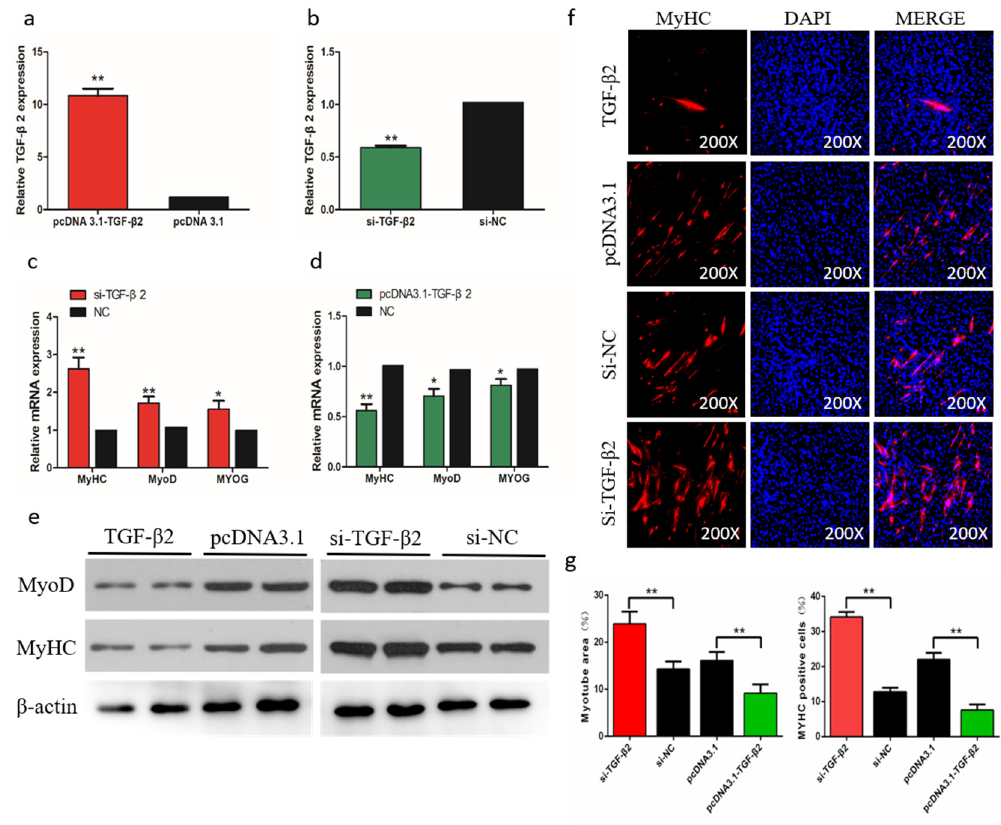
Figure 8. Effects of TGF- β 2 on differentiation of skeletal muscle satellite cells (SMSCs). ( a , b ) After overexpression or interference with TGF- β 2, qRT-PCR was used to detect the expression of TGF- β 2 in SMSCs. ( c , d ) The relative expressions of MyoD, MyHC, and MyoG mRNA in SMSCs differentiated for 48 h. ( e ) Western blot detects protein levels of myogenic marker genes after inhibition and overexpression of TGF- β 2. ( f ) Representative images of immunofluorescent staining of differentiated SMSCs (200×). Myosin: Red, a molecular marker of myogenesis; DAPI: Blue, cell nuclei; Merge: The fusion of SMSCs into primary myotubes. ( g ) Myotube area (%) and MYHC positive cells (%) after transfection of si-TGF- β 2, pcDNA3.1-TGF- β 2, or NC. Data are expressed as mean ± SEM ( n = 3). * p < 0.05; ** p < 0.01 vs. NC.